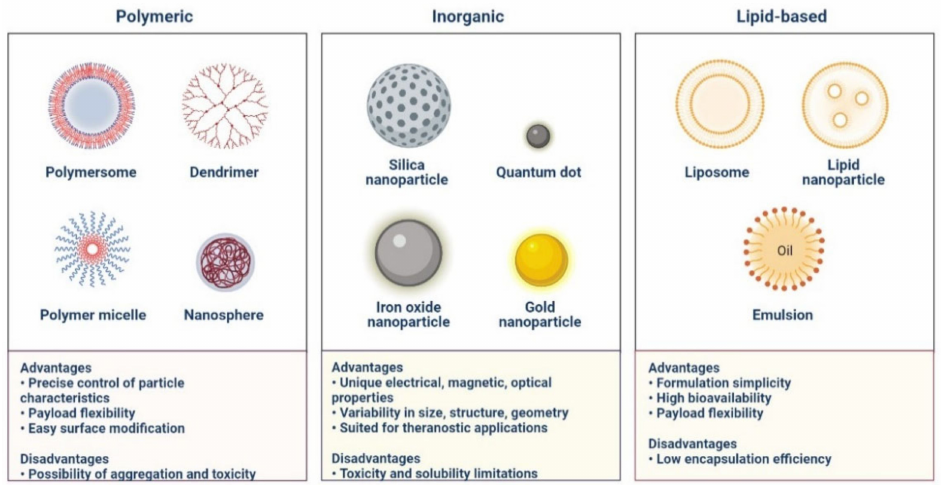
Figure 24. Classes of